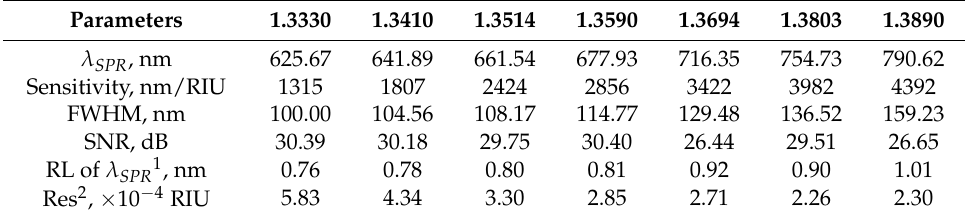
Table 1. Comparison of sensor parameters corresponding to refractive index of seven samples.